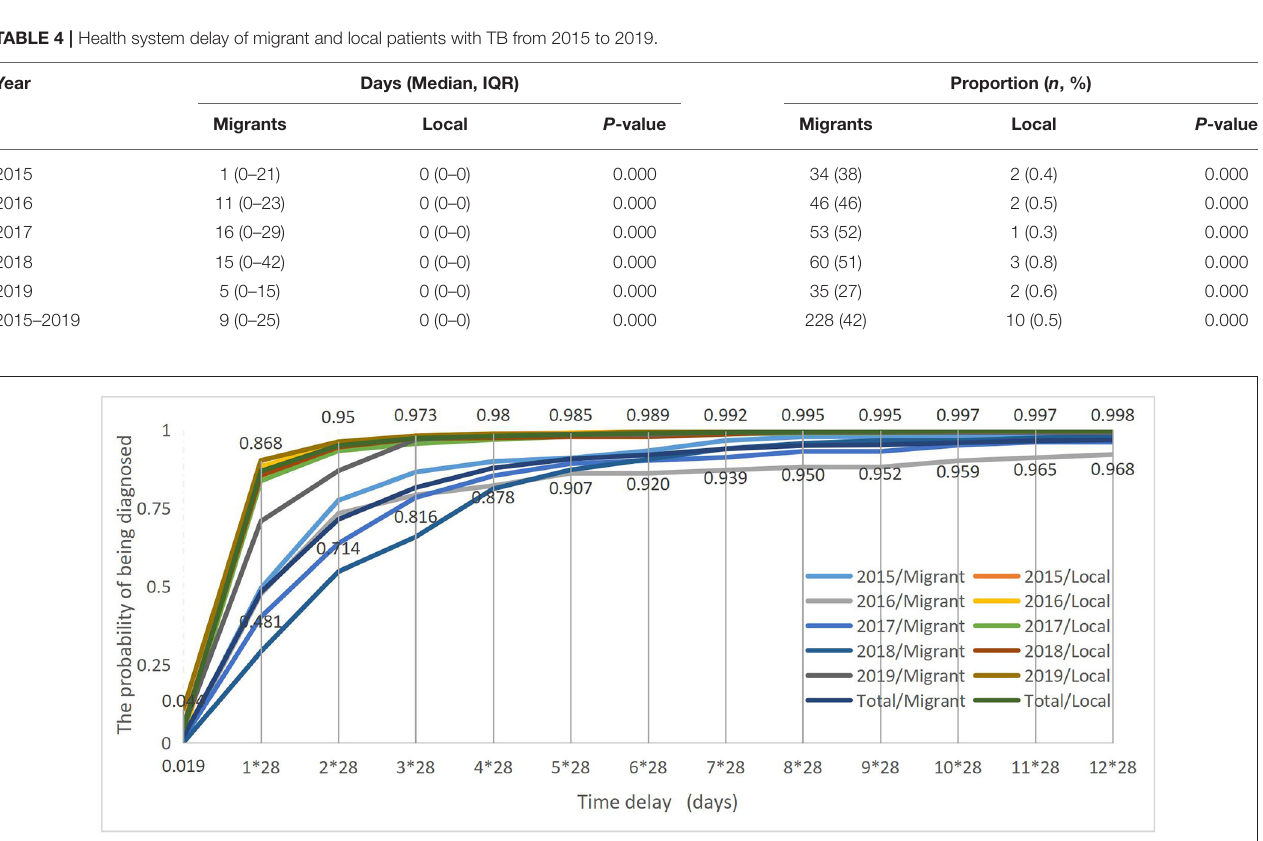
FIGURE 1 | Total delay curves between migrant and local patients with TB from 2015 to